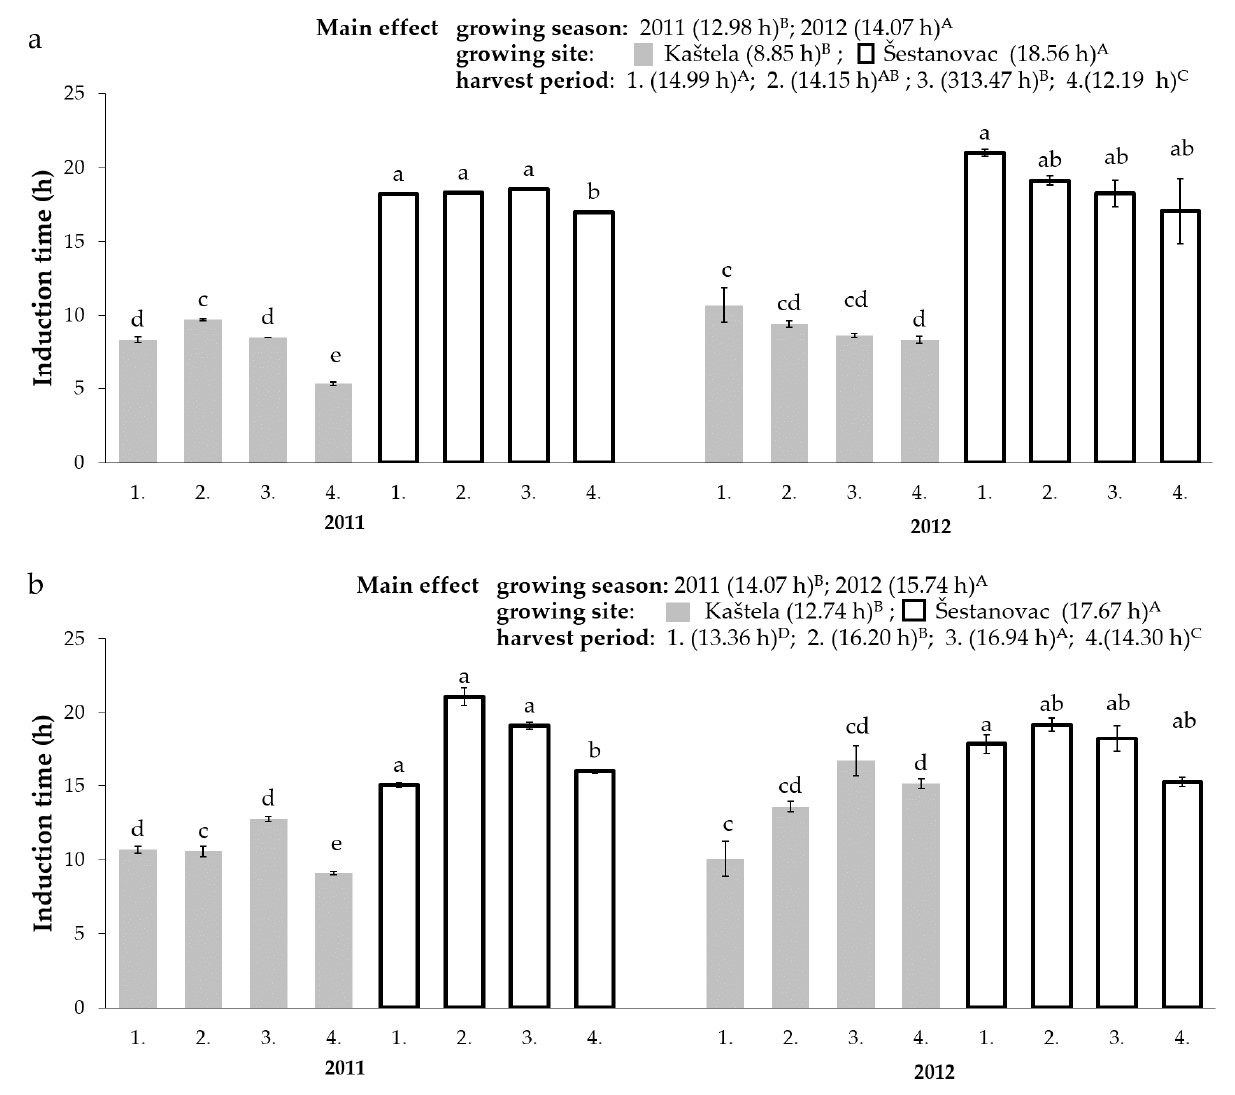
Figure 1. Oxidative stability of Oblica ( a ) and Leccino ( b ) virgin olive oils during ripening from two distinct olive orchards (Kaštela and Šestanovac) in two consecutive years. Bars marked with different lowercase letters for each growing season are significantly different, while different upper-case letters indicate differences within main effects (growing season, growing site, and harvest period), determined by a three-way test ANOVA (Tukey’s test, p ≤ 0.05). 1–4, harvest period.